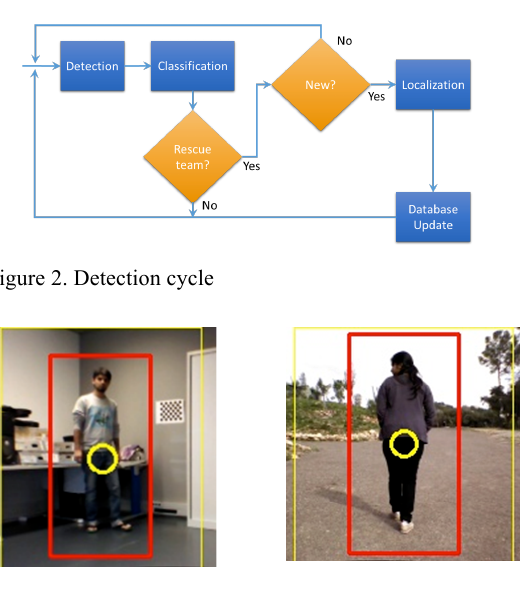
Figure 3. Bounding Box principle Data fusion